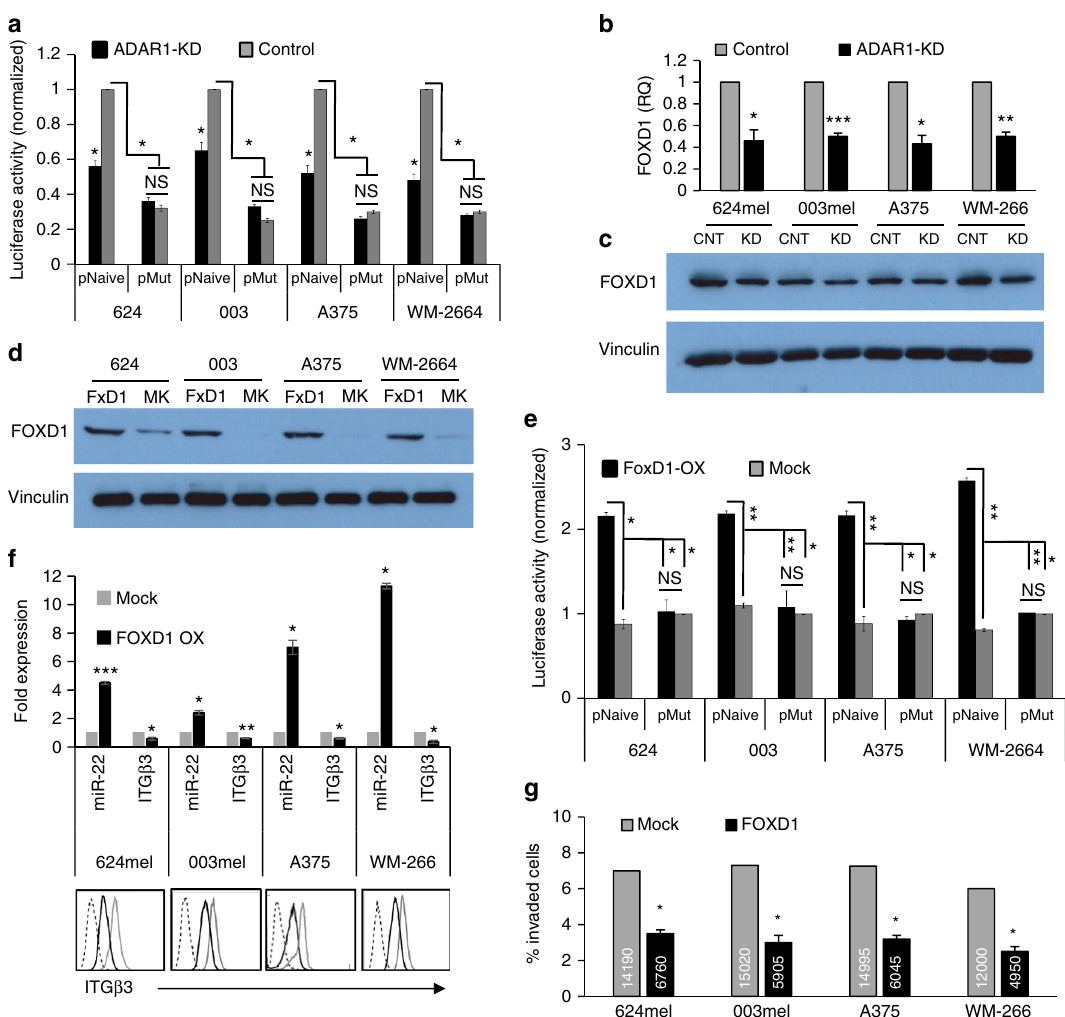
Fig. 4 FoxD1 overexpression leads to decreased melanoma invasion. a The impact of reduced ADAR1 expression (ADAR1-KD, KD) on miR-22 promoter was evaluated by normalized luciferase activity of ADAR1-KD cells as compared to control cells (control, CNT) expressing naive promoter (pNaive) or mutated promoter (pMut) with point mutations at the FoxD1 designate binding site. b Expression of FoxD1 in ADAR-KD melanoma cell lines, as indicated in the fi gure, as compared to control cells was determined by b qRT-PCR and c western blot. d The expression of FoxD1 in four melanoma cell lines, as indicated, that were stably transduced with FoxD1 overexpression plasmid (FoxD1-OX, FxD1) or Mock plasmid (MOCK, MK) was examined by western blot. e The impact of increased FoxD1 expression on miR-22 promoter was evaluated by normalized luciferase activity of FoxD1-OX cells as compared to Mock cells expressing naive promoter (pNaive) or mutated promoter (pMut) with point mutations at FoxD1 designate binding site. f miR-22 expression was evaluated by qRT-PCR; expression of ITGB3 was determined by qRT-PCR and by extracellular staining with an anti-ITGB3-FITC-conjugated antibody and the corresponding isotype control. g Invasive behavior of cells using standardized Boyden chamber assay. The number of cells was evaluated for 24 h post seeding. Numbers in the bars represent the absolute cell count of invading cells. Results for a , b and e – g represent the mean ± SE of three biologically independent experiments, each performed in triplicates. Results for c and d and FACS stains in f are representative experiment out of three performed. Asterisks represent P values: * P < 0.05; ** P < 0.01; *** P < 0.001 (two-tailed t can in fl uence miRNA biogenesis by binding to DGCR8, Dicer, or directly to pri-miRs 27,28,33 .